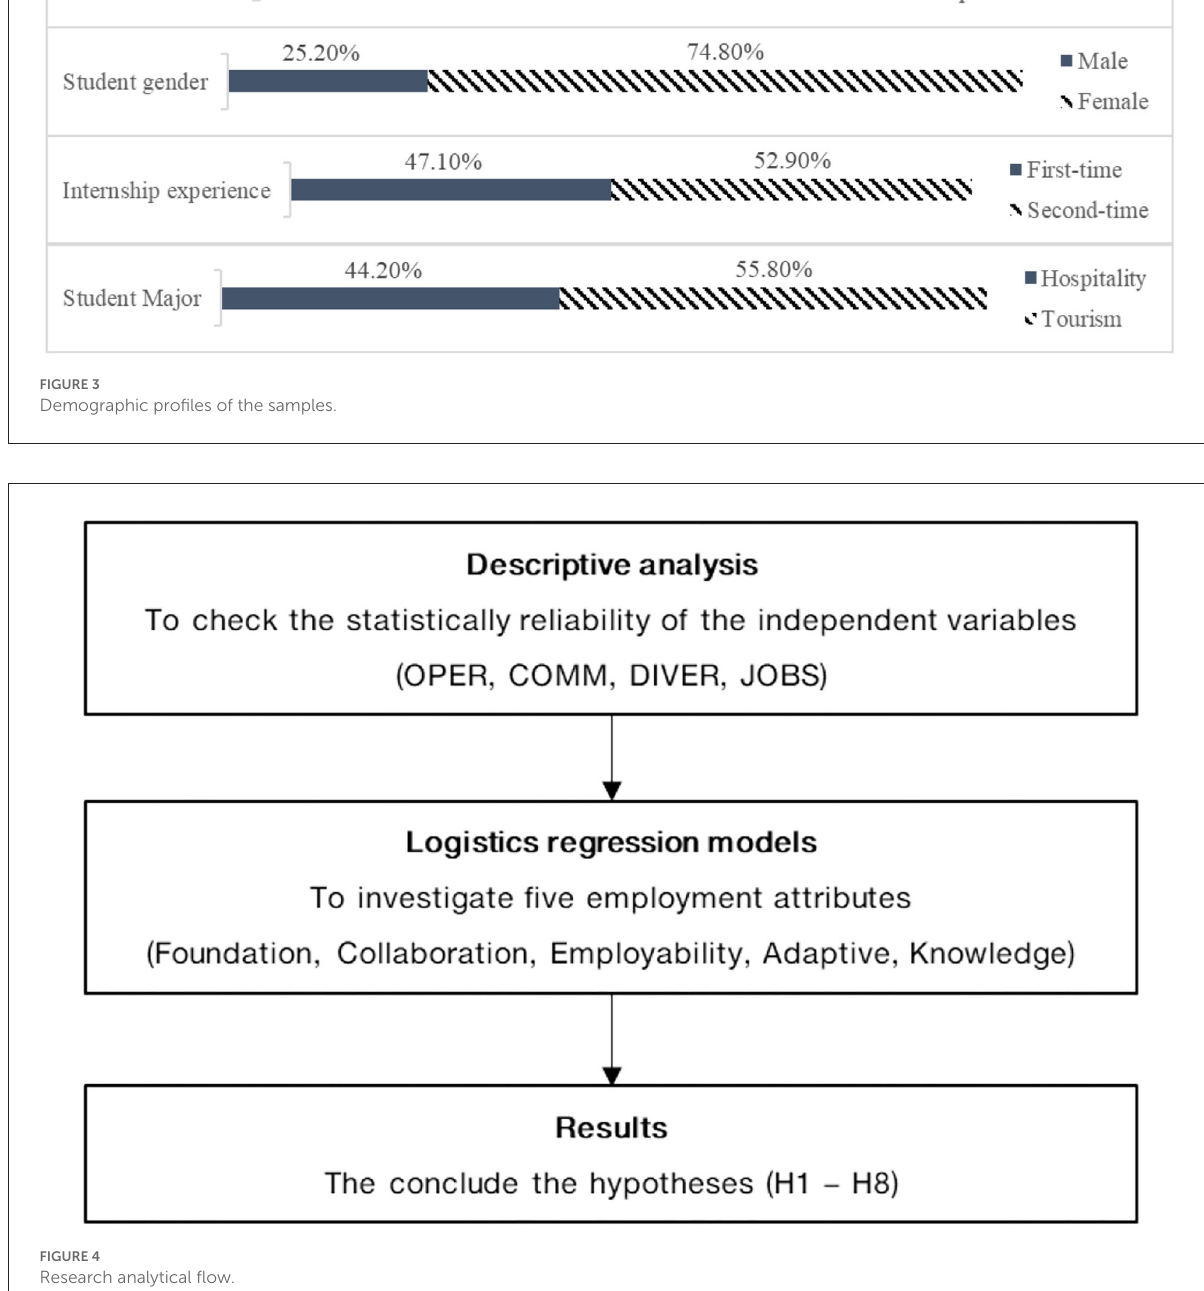
FIGURE4 Research analytical